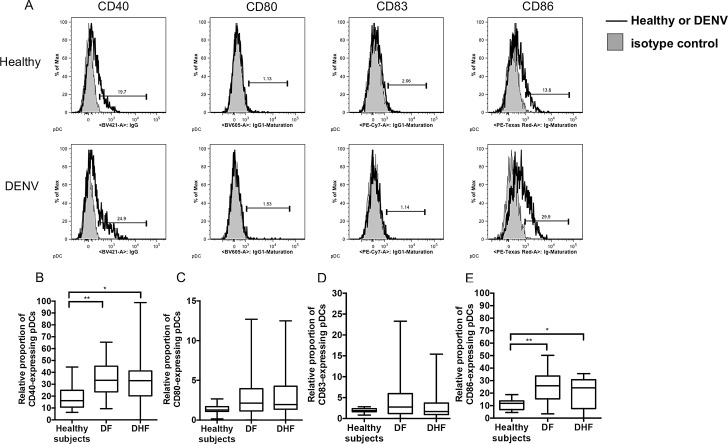
Comparison of the expression of potential markers of relative pDCs maturation during acute DENV infection.(A) Representative histogram plots showing expression of the potential maturation markers on pDCs in blood samples from healthy subjects (solid black line, upper panel) and DENV-infected patients (solid black line, lower panel). The shaded grey histograms represent profiles obtained using isotype controls. The relative proportion of CD40 (B), CD80 (C), CD83 (D), and CD86 (E) -expressing pDCs were compared between healthy subjects and DENV-infected patients of both DF and DHF patients. The box plot shows the median value (horizontal line in the box). The box and whisker represent 25th to 75th, and 10th to 90th interquartile range, respectively. P values were determined by the Dunn’s post-test after Kruskal-Wallis test for comparison of three groups. (* p < 0.05 and ** p < 0.01).